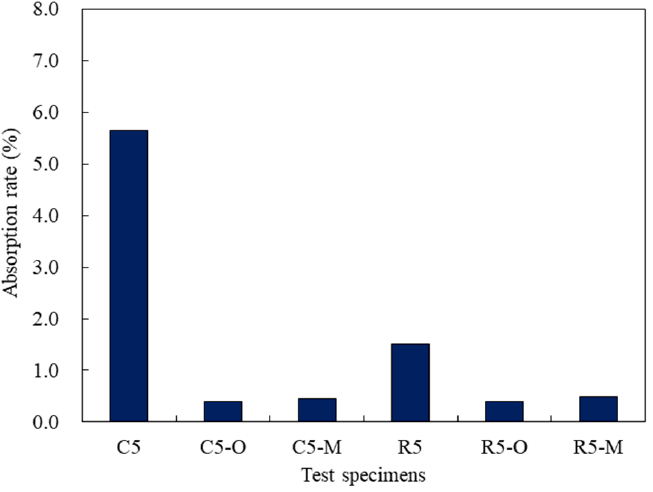
Figure 6. Water absorption of the cement mortar mixed with water repellents.